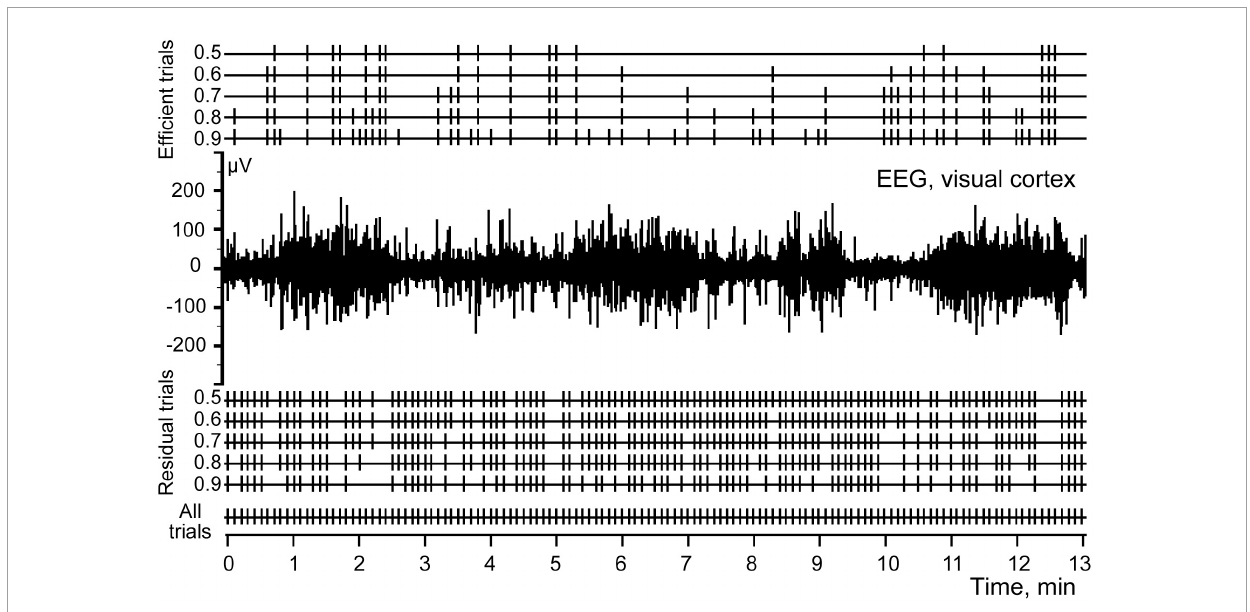
FIGURE4 Efficient and residual trials for P200 component of the evoked potential, calculated at S thresholds ranging from 0.5 to 0.9.